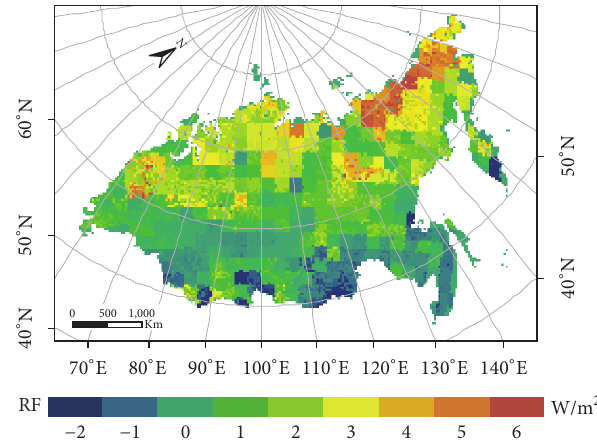
Figure 6: The annual NRF caused by the snow cover changes from the 1970s to the 2010s. Figure 7: The monthly and annual NRF in Siberia from the 1970s to